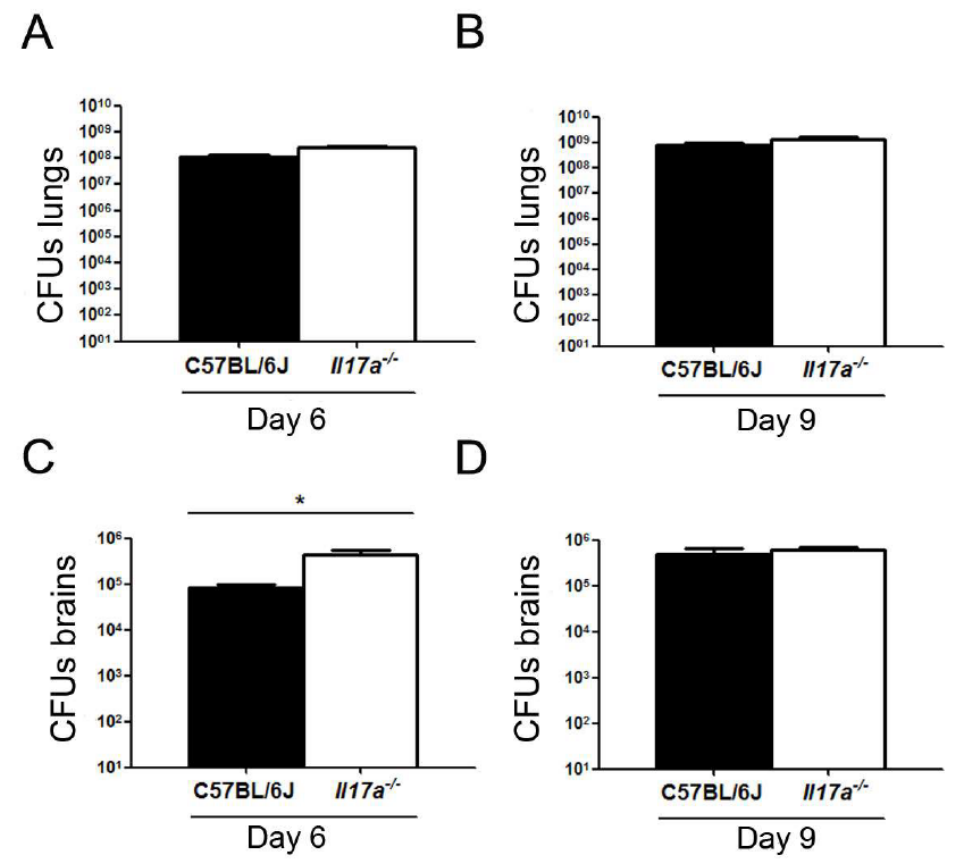
Figure 4. Fungal burden and spread of C. neoformans in C57BL/6J and Il17a -/- mice. C7BL/6J mice (black bars) and Il17a -/- (white bars) infected as described in M&M were sacrificed after 6 ( A , C ) and 9 ( B , D ) days of infection, and number of CFUs was quantified in lungs ( A,B ) and brains ( C,D ). Asterisk indicates statistically significant differences.